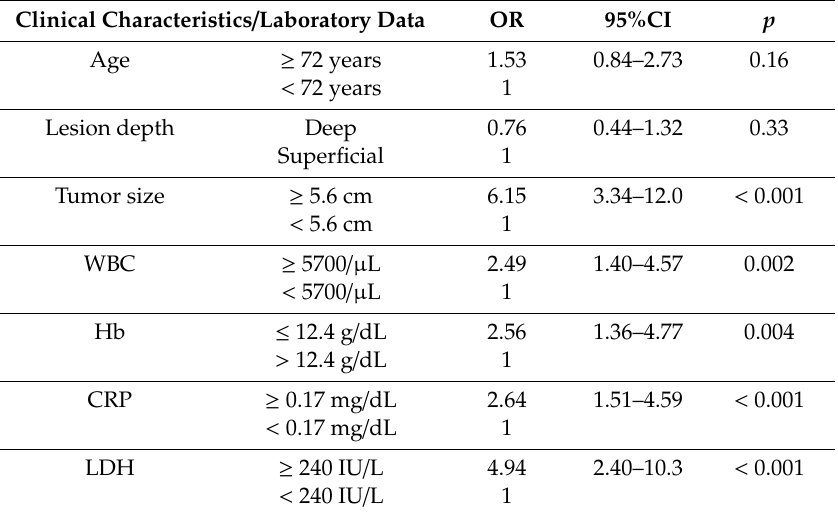
Table 5. Multivariate analysis for predicting factor for soft tissue